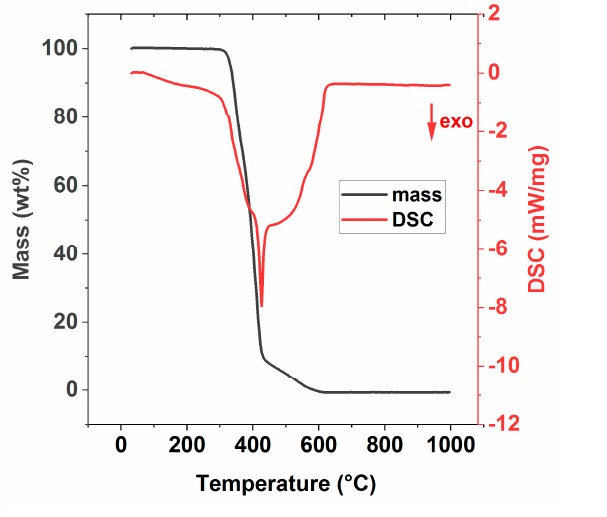
Table 1. Physicochemical properties of the neat polymerized ionic liquids, including ionic conduc- tivity values at 25 °C, glass transition temperatures (T g ), onset temperature of thermal decomposi- tion (T Dec (Onset)) and temperature at which 98 wt% of the sample mass is remaining in thermo- gravimetric analysis (T Dec (98 wt%)). Polymer